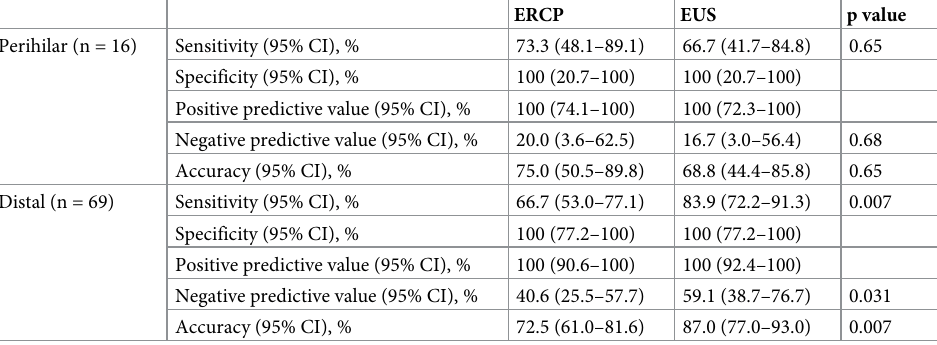
Table 5. Subgroup analysis of diagnostic performance of EUS and ERCP according to biliary stricture